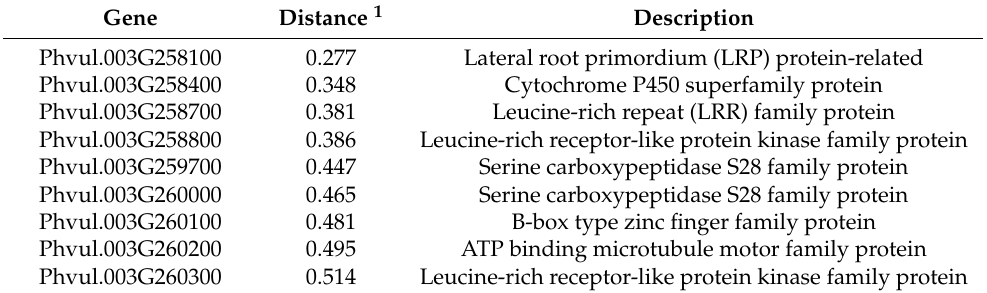
Table 6. Annotation of candidate genes with a confidence interval (1.001 Mb) of significant